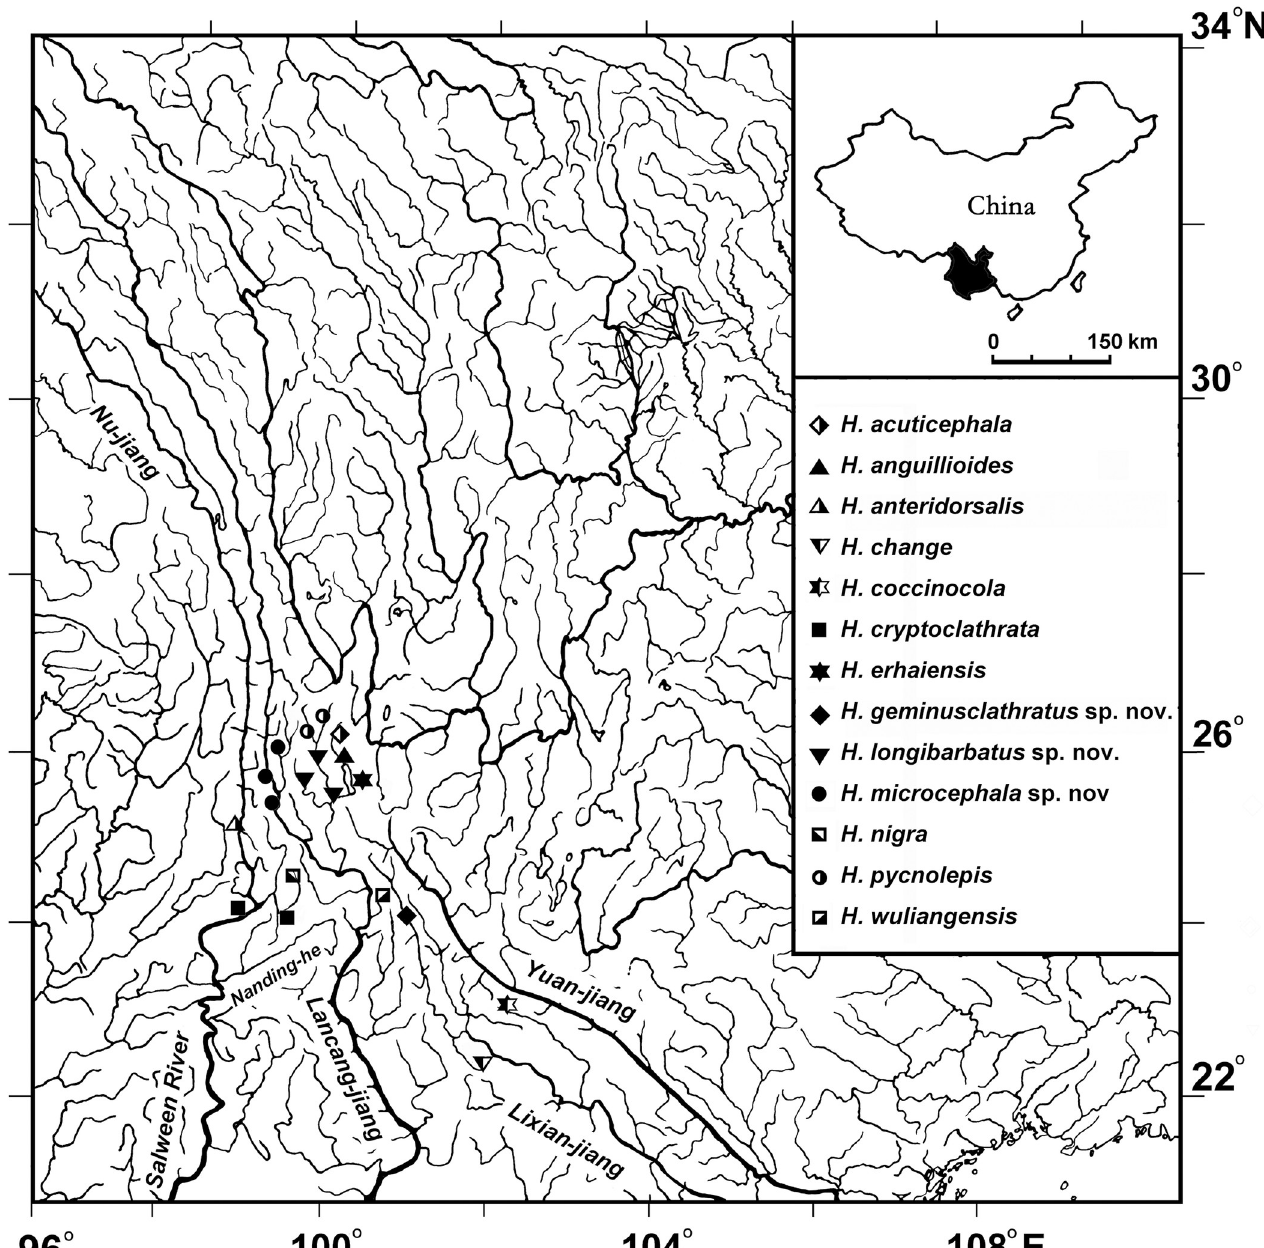
Fig 5. Distribution map of the densely-scaled group of Homatula . A symbol may represent several adjacent localities.